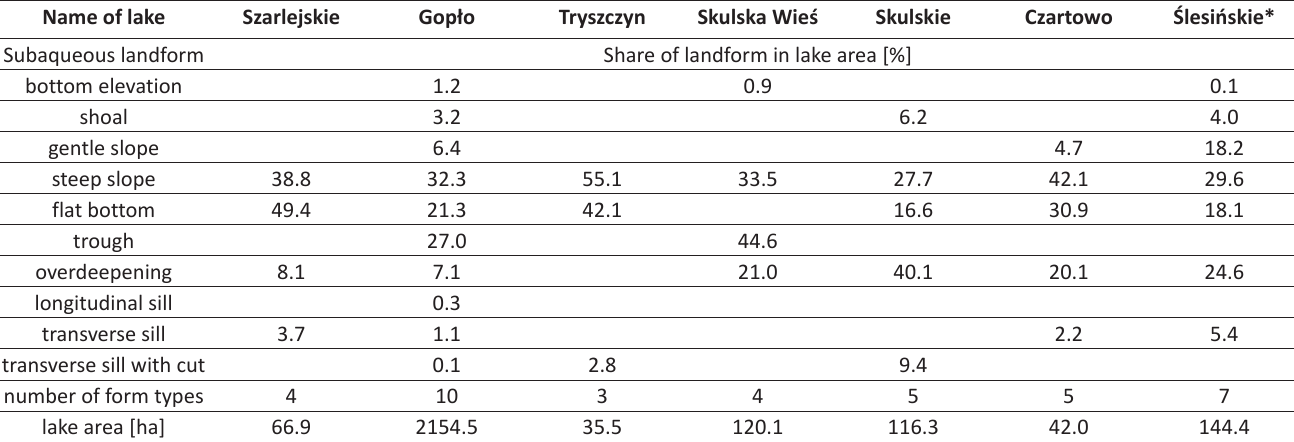
Table 2 . Area of subaqueous relief types as a proportion of lake surface area, for the largest lakes in the research area. Name of